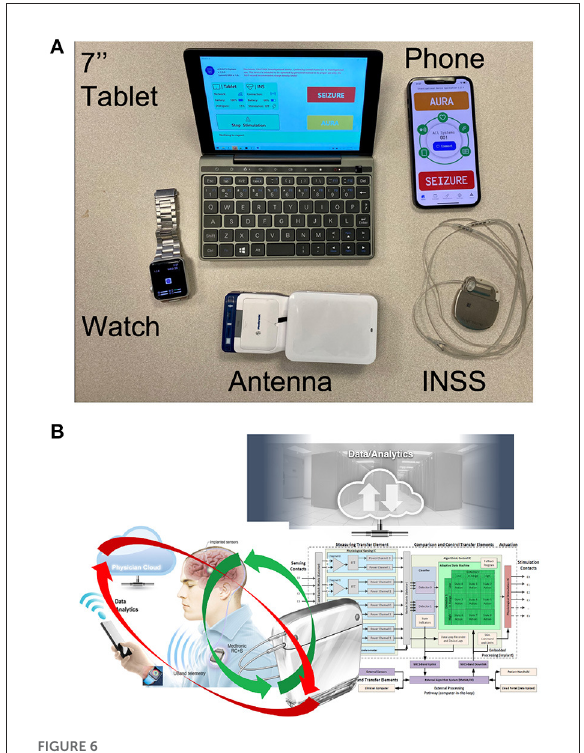
FIGURE6 The components of the next generation epilepsy system. (A) Tablet computer and smartphone running epilepsy patient assistant (EPA). The EPA application integrates communication between all hardware elements (smartwatch, tablet, phone, and implanted neural sensing and stimulation (INSS) device). The system requires a proprietary antenna to communicate between the INSS and the tablet. (B) The brain co-processor system schematic shows the interaction between the implanted device, smartphone, smartwatch, and cloud computing environment (adapted from Kremen et al.